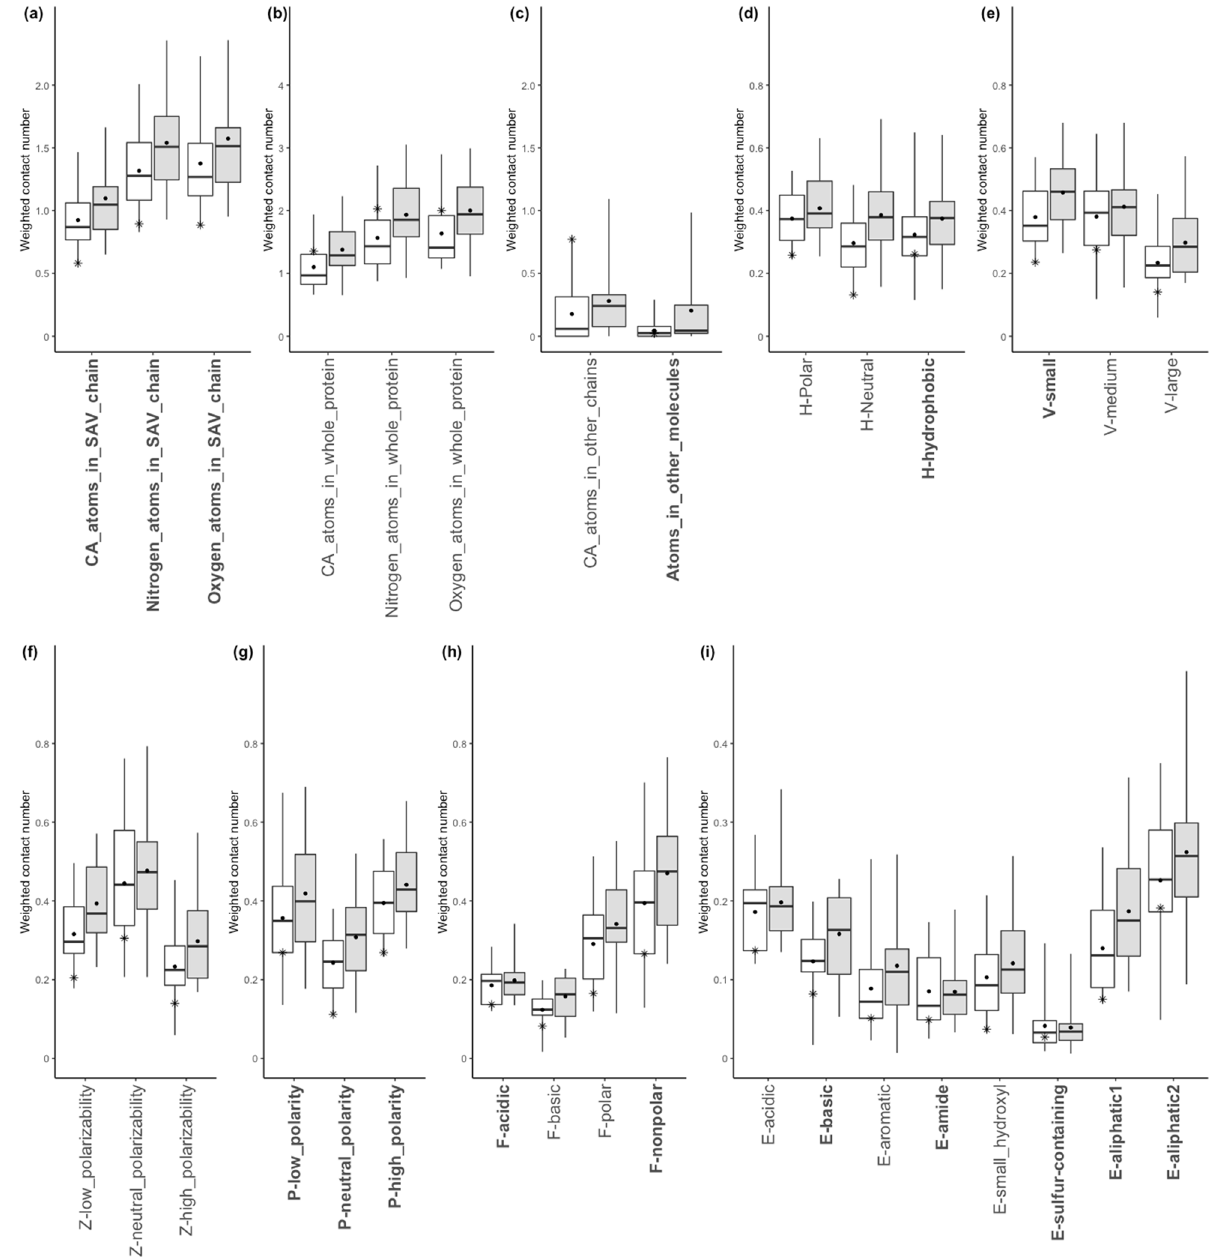
Figure 7. Boxplots of the microenvironment descriptors in the GLU that are altered to the GLY subgroup. All microenvironment descriptors are divided into nine groups: ( a ) atoms in SAV chain, ( b ) atoms in whole protein, ( c ) atoms in other chains or molecules, ( d ) H -group, ( e ) V -group, ( f ) Z -group, ( g ) P -group, ( h ) F -groups, and ( i ) E -groups. The white and grey boxes represented the distribution of cancer-related and neutral SAVs. The label of selected descriptors by the genetic algorithm are bold in the x -axis. The symbol stars denote the values of each feature in the case of E194G located at